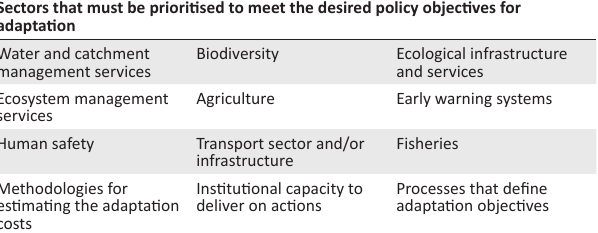
TABLE 1 : Sectors that must be prioritised for adaptation. Sectors that must be prioritised to meet the desired policy objectives for adaptation